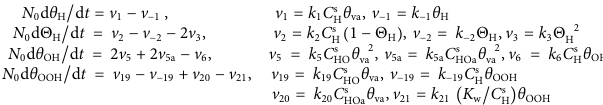
Frontiers in Energy Research |